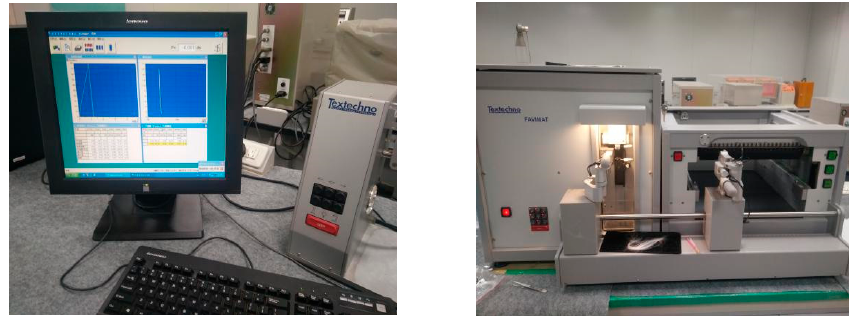
Figure 2. Favimat-Airobot automated monofilament fiber tester. Table 3. Properties of fibers.